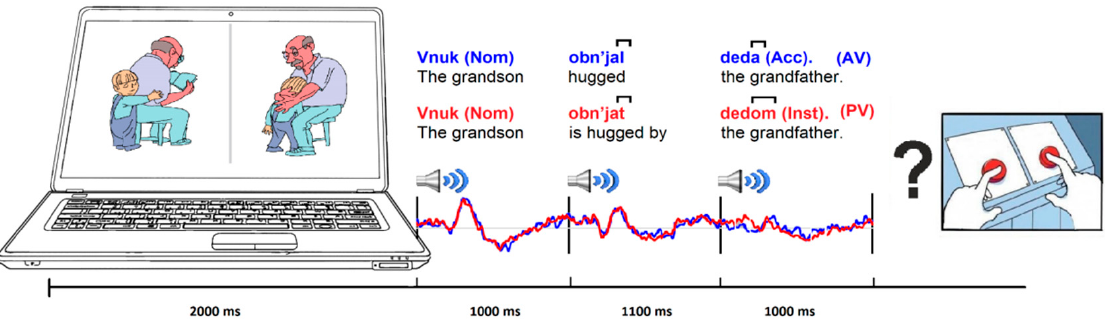
Figure 1. Experimental design in the sentence-picture matching task. Blue—active voice (AV), red—passive voice (PV), the frame marks morphemes that differed AV vs. PV sentences. Semantically distinctive morphemes are marked with square brackets. The vertical lines indicate the beginning of the stimulus sounding.